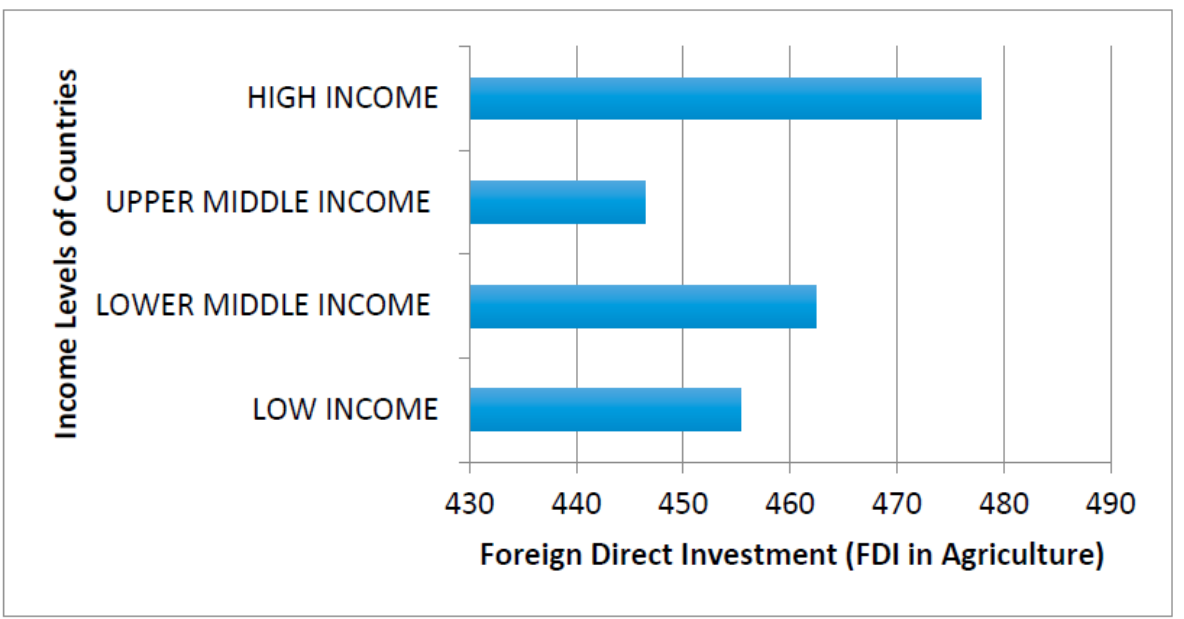
Figure 1. Foreign direct investment in agriculture (USD). Source: FAO and UNCTAD Trade and Investment Report.